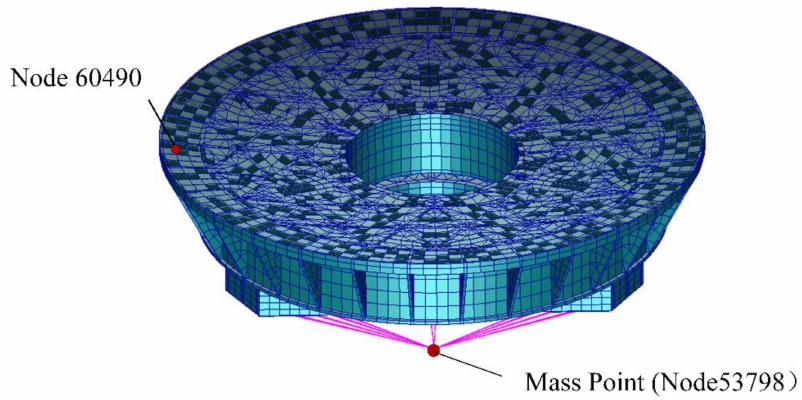
Figure 4. Finite element model of the primary mirror